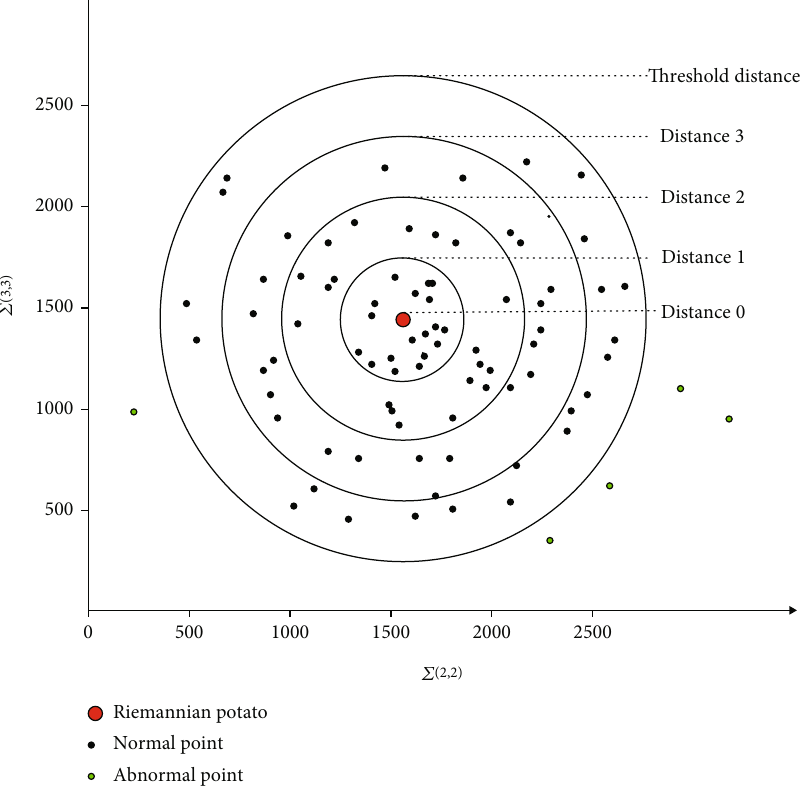
Figure 4: Schematic diagram of Riemann potato.